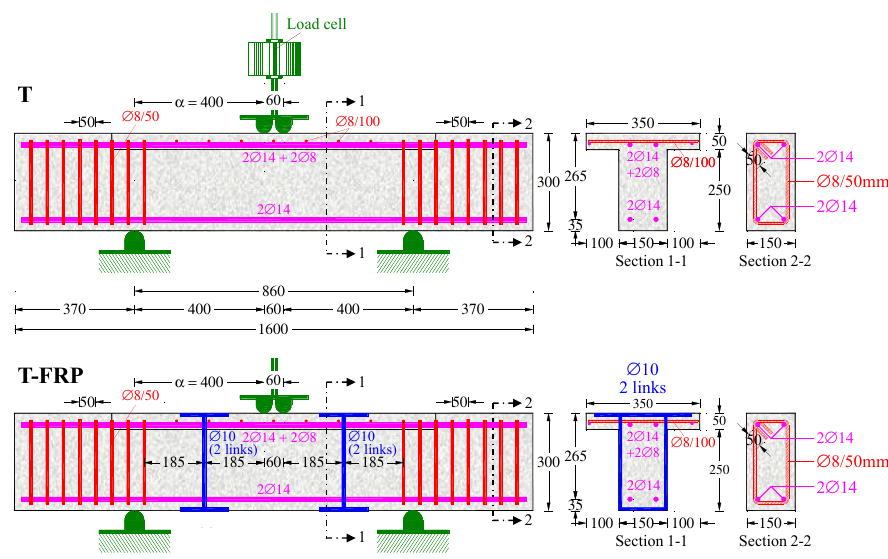
Figure 2. Geometry and reinforcement details of the flanged beams with T-shaped cross-sections.